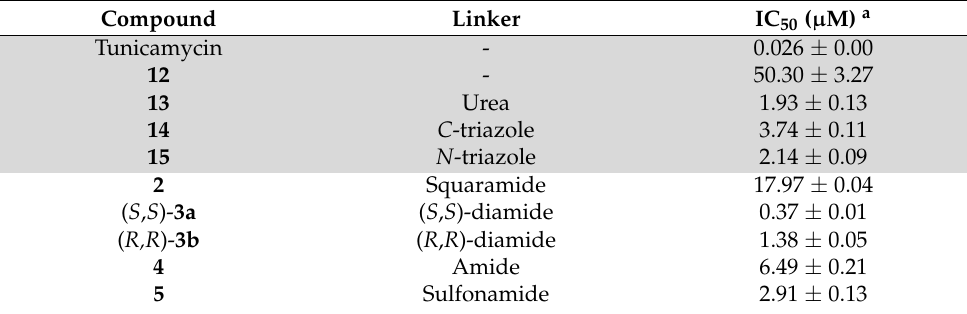
Figure 4. Structure of the amino precursor 12 , urea-, C- and N- triazole-containing inhibitors 13 , 14 and 15 that we previously synthesized. Table 1. Inhibitory activity of compounds 2 – 5 and 12 – 15 against MraY AA .